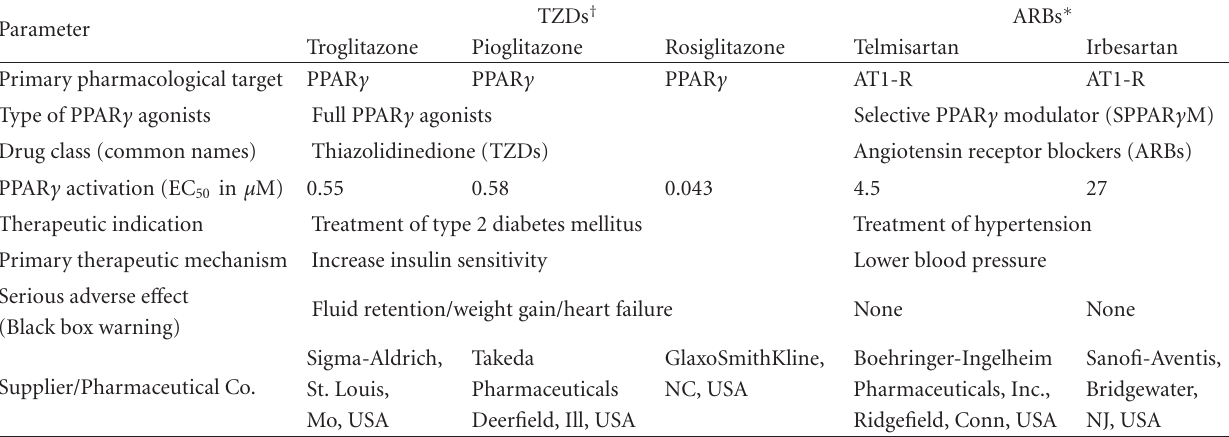
Table 3: Comparison of pharmacological and other relevant properties of thiazolidinedione (TZD) full PPAR γ agonists and dual